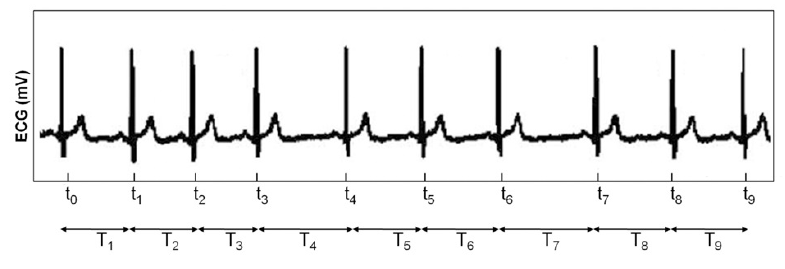
Figure 1. An R-R interval time series